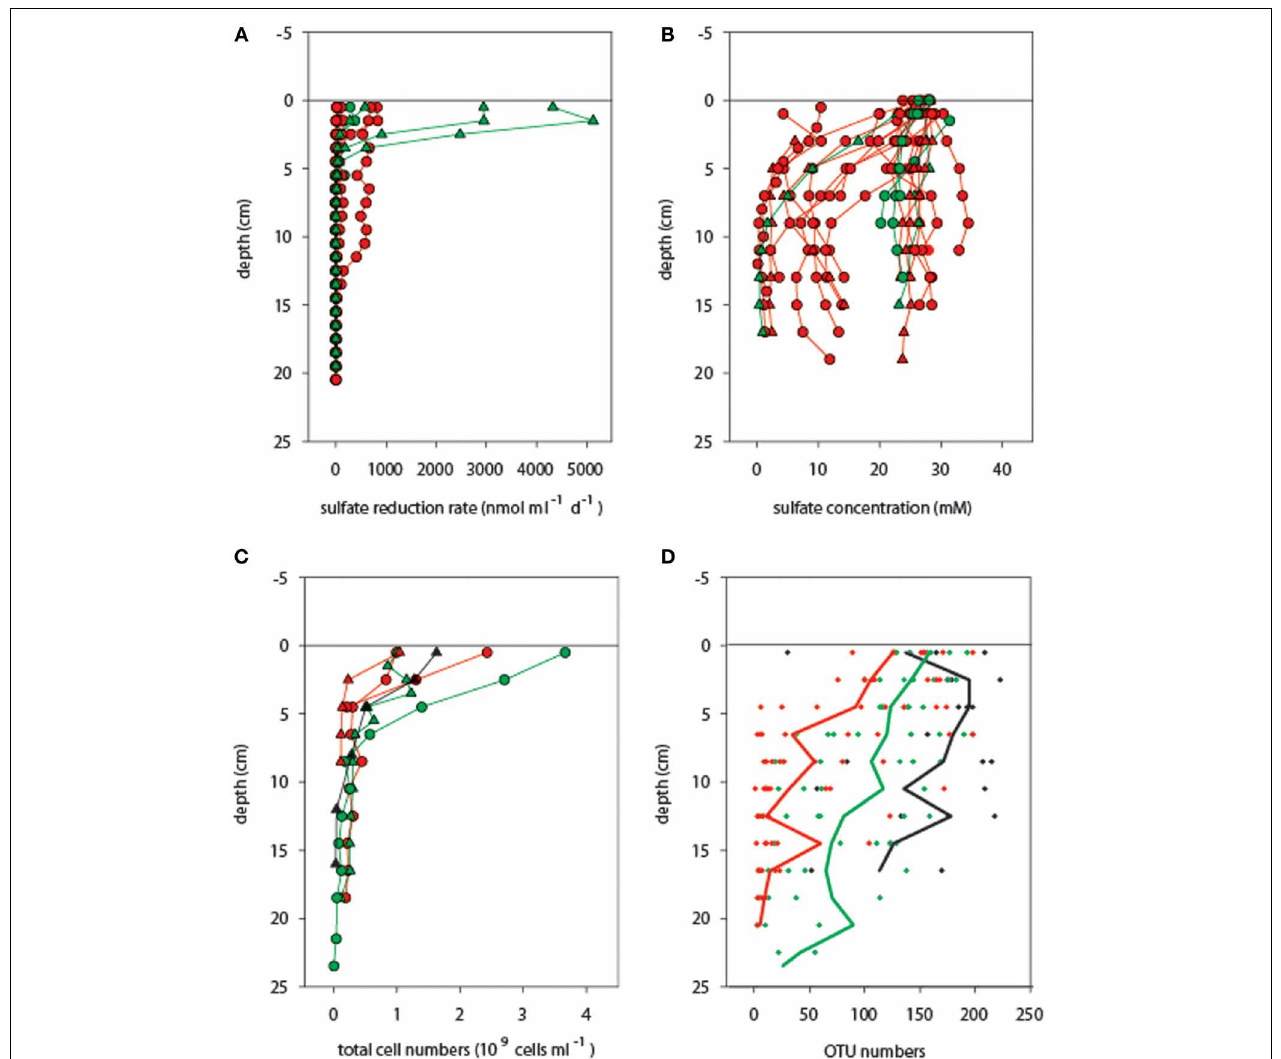
FIGURE 3 | Activity and biomass of microbial communities associated with different temperature ranges. (A) Potential sulfate reduction rates and (B) sulfate concentrations were determined in adjacent cores (not available for cold cores). Total single cells (C) and OTU numbers (D) generally decreased with increasing sediment depth [the lines in (D) indicate average